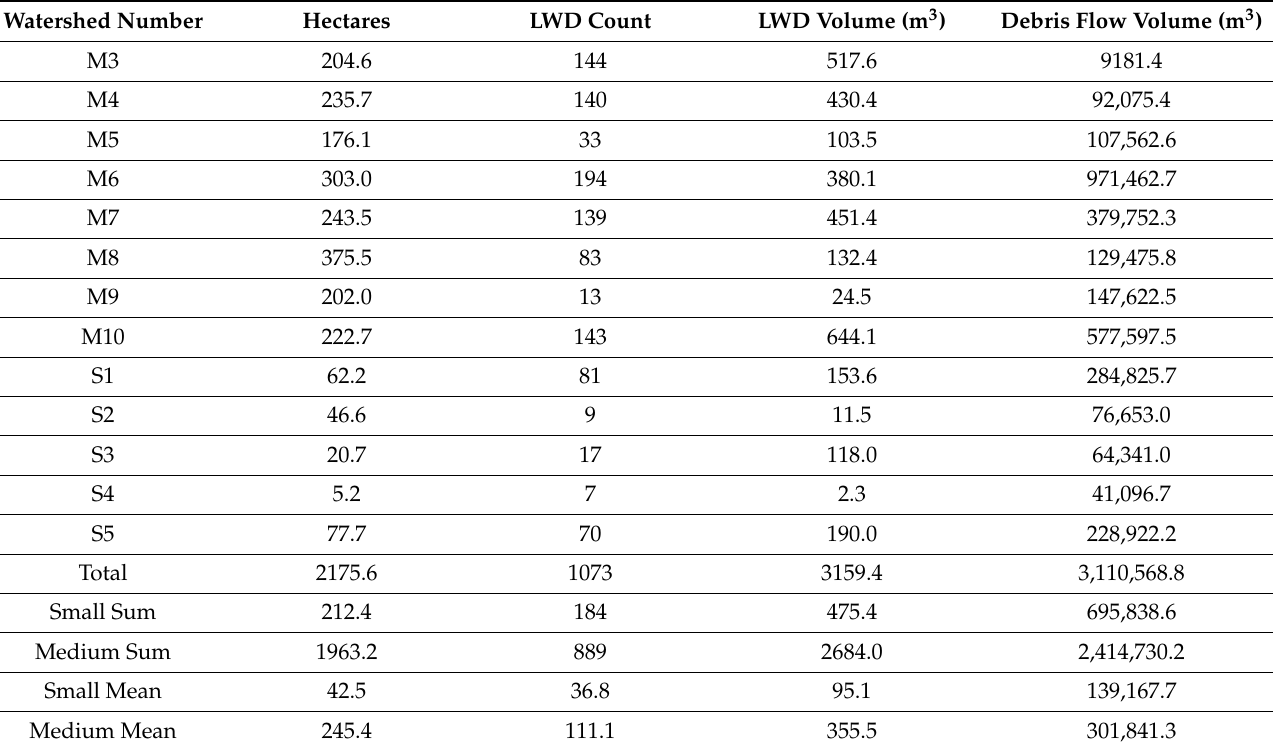
Table 2. LWD counts and volumes from each watershed.